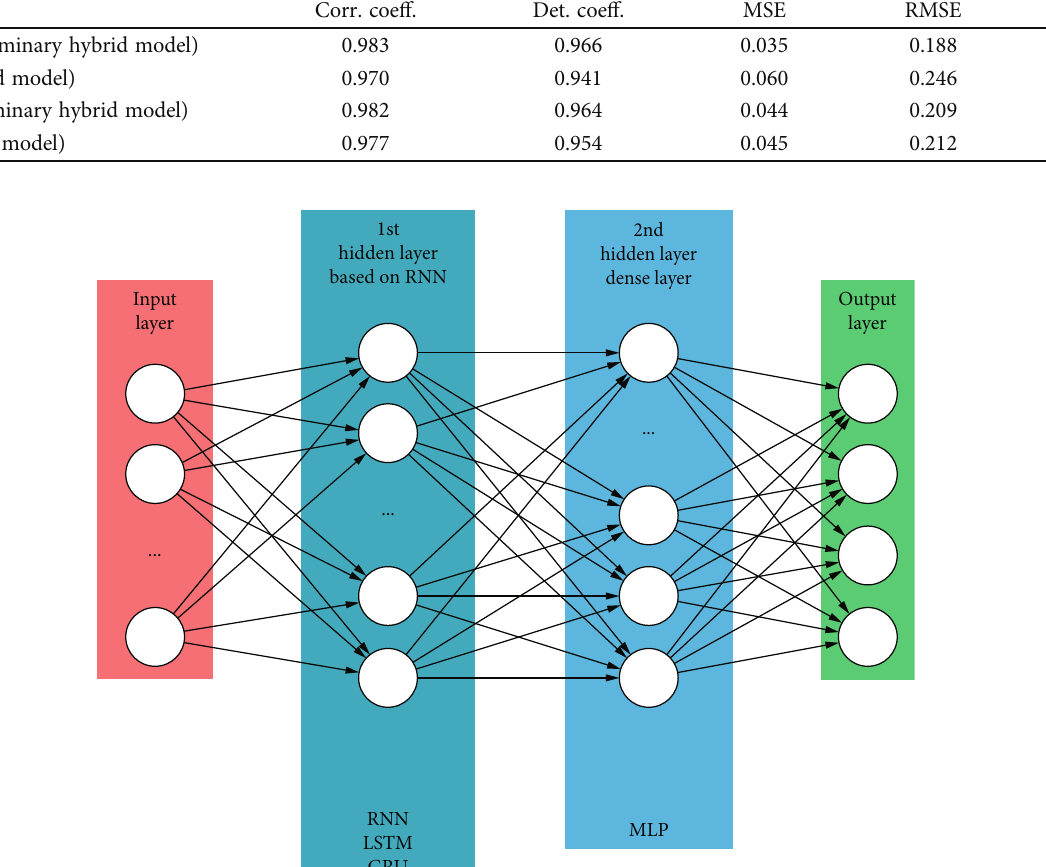
Figure 5: Base architecture for RNN-ANN models.